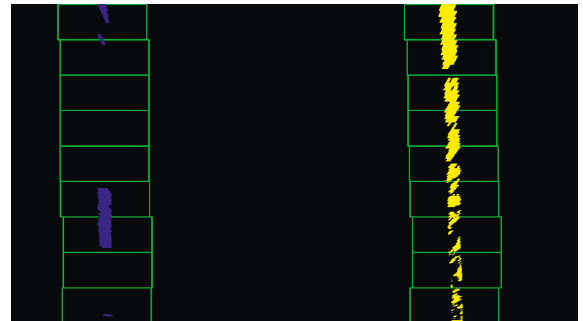
Figure 12: Result of sliding window.